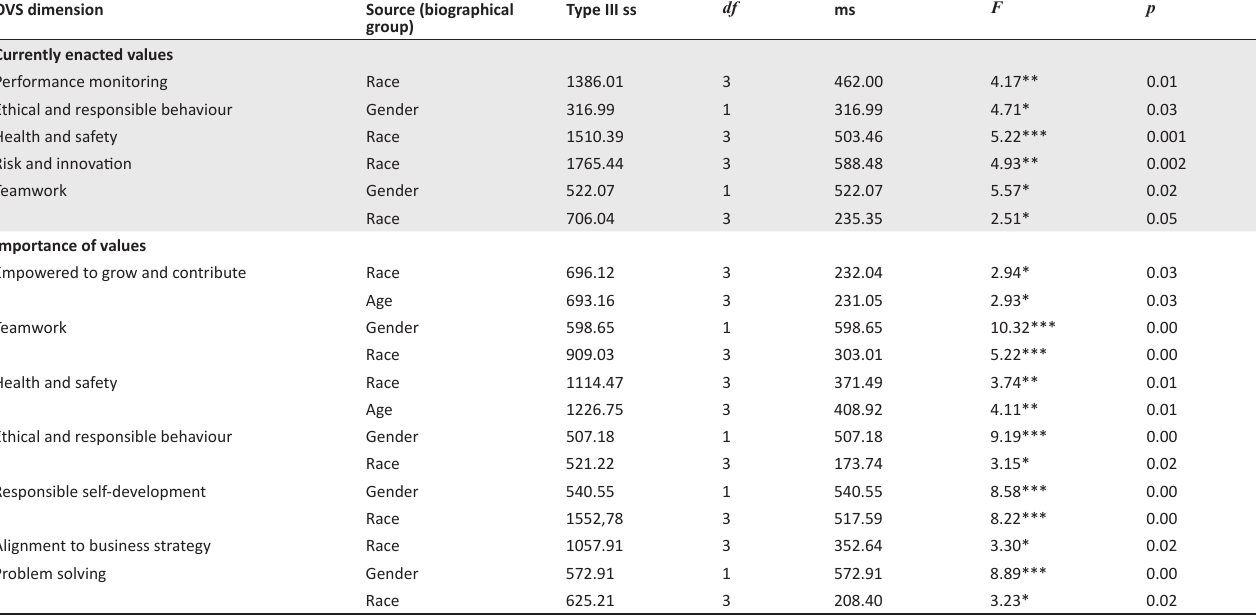
TABLE 3: Organisational Values Scale- ANOVA summary of the significance of race, gender and age groups on Organisational Values Scale dimensions ( n = 988). OVS